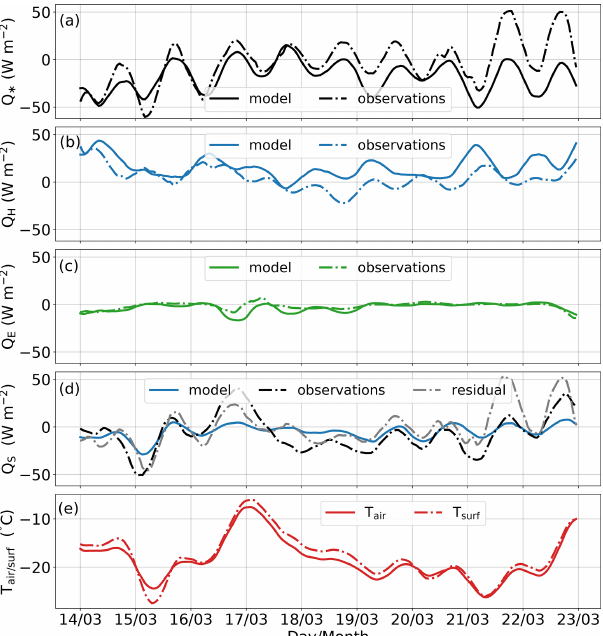
Figure 8. Comparison between observed and modeled hourly means of all constituents of the energy budget at the snow surface from 14 to 23 March 2020. The residual snow heat flux is obtained by subtracting the turbulent heat fluxes from the net radiation. Also shown are the air and surface temperatures during this